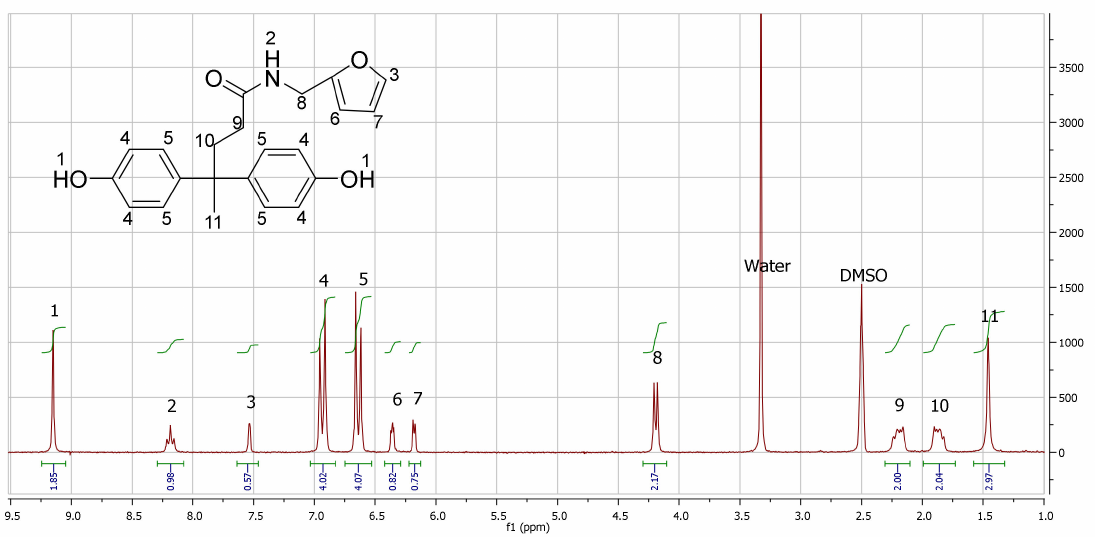
Figure 1. NMR spectrum of